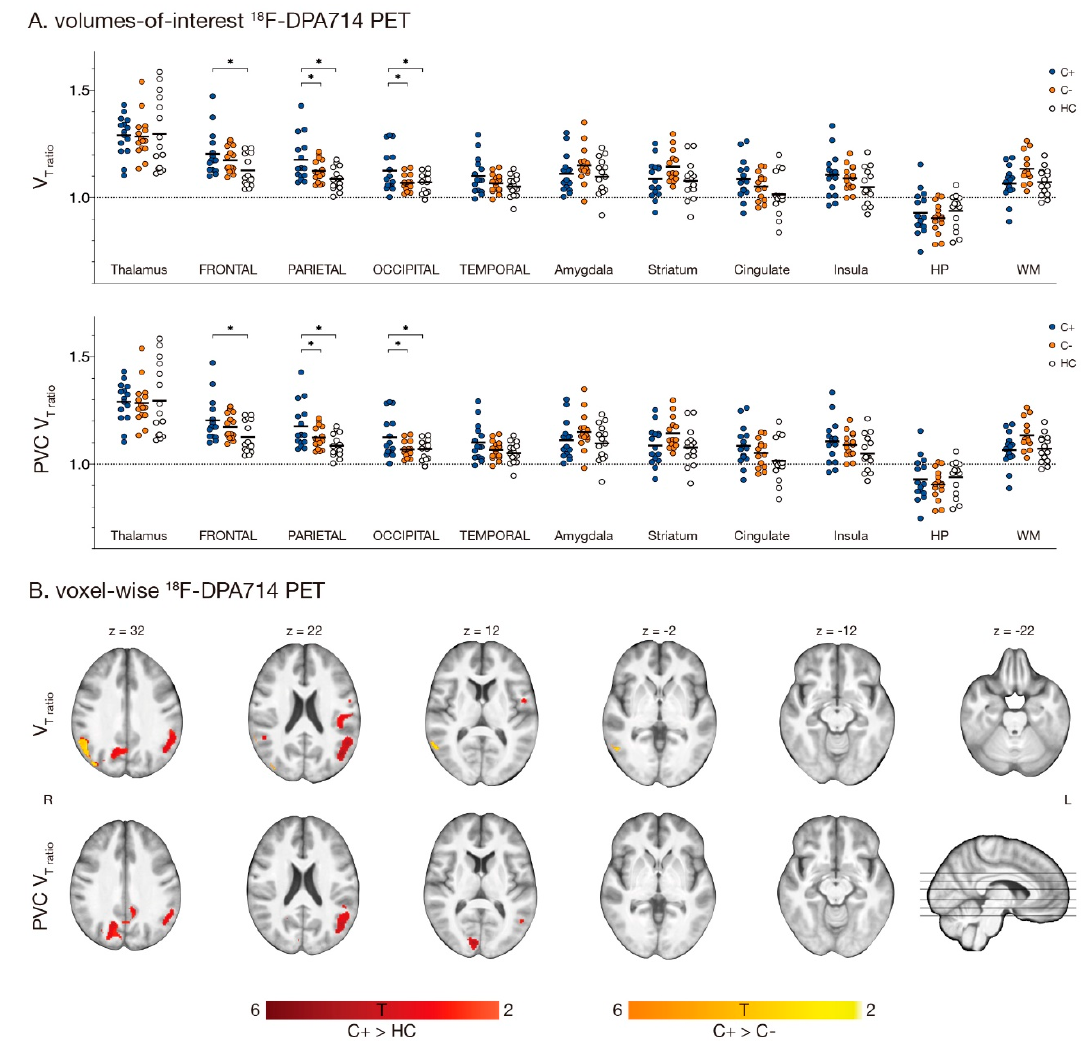
Figure 2. Regions showing [ 18 F]DPA714 V T-ratio differences with LGA. Fifteen chemotherapy-treated patients (C+) were assessed for [ 18 F]DPA714 V T-ratio and compared to 15 chemotherapy-naïve patients (C − ) and 15 healthy women (HC). ( A ) Volumes-of-interest based logan-graphical analysis (LGA) results of 11 volumes of interest are presented, showing higher V T-ratio in C+ patients compared to HC in the parietal lobe. After partial volume correction (PVC), C+ patients showed higher V T-ratio compared to C − and HC in the parietal and occipital lobe and additionally in the frontal lobe when compared to HC (* p < 0.05). ( B ) Voxel-based whole brain LGA results are presented, showing higher V T - ratio in C+ patients compared to HC (blue) and C − patients (orange) in the occipital and parietal lobe. After PVC, only differences between C+ and HC persisted for V T-ratio images (all p uncorrected < 0.005, p cluster FWE-corrected < 0.05). Section numbers refer to Montreal Neurological Institute coordinates. Abbreviations: HP = hippocampus, V T = total distribution volume, WM = white